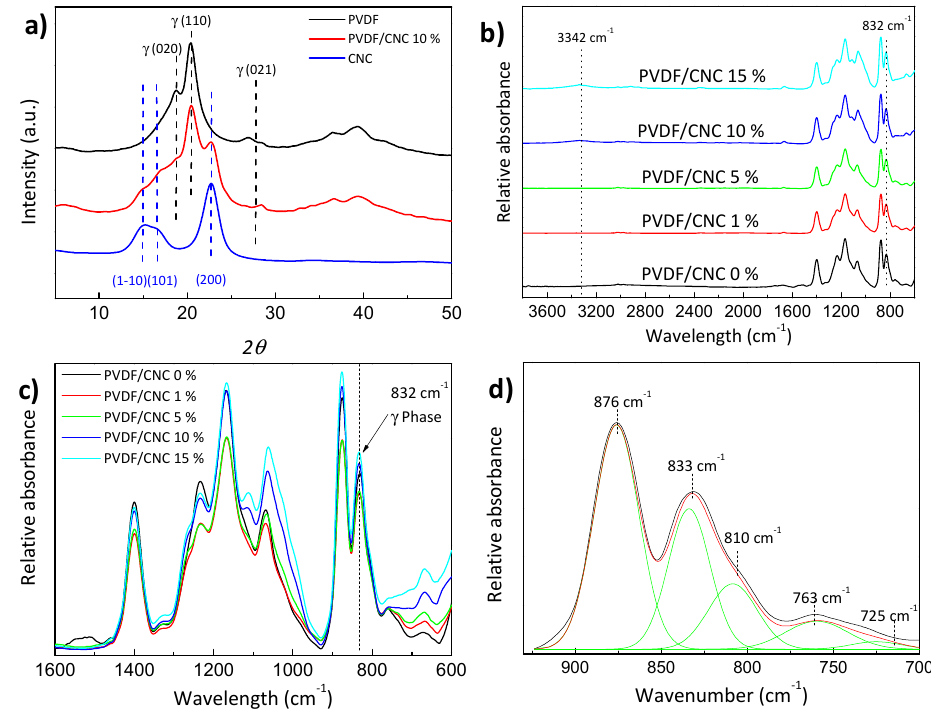
Figure 3. ( a ) Wide angle X-ray diffraction (WAXD) patterns; ( b ) FTIR spectra and ( c ) enlarged FTIR spectra of the PVDF / CNC nanocomposites and ( d ) peak deconvolution of the FTIR spectra in the 925–700 cm − 1 region for PVDF.